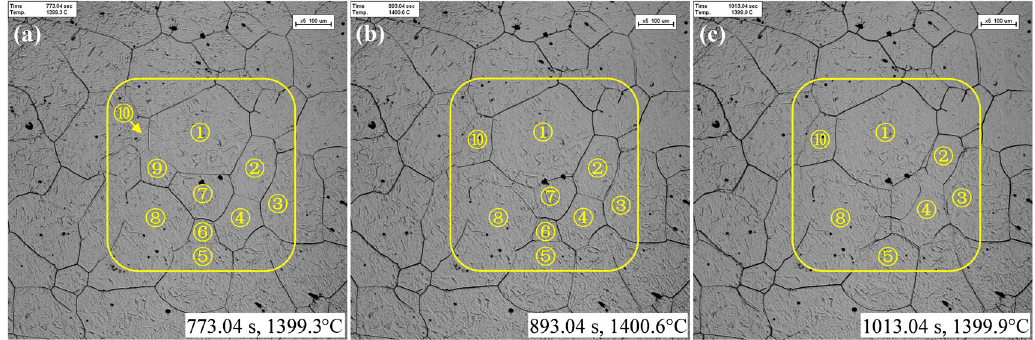
Figure 12: In situ observation of grain growth in the heat preservation process at 1,400°C of ( a ) 773.04 s, ( b ) 893.04 s and ( c ) 1013.04 s.